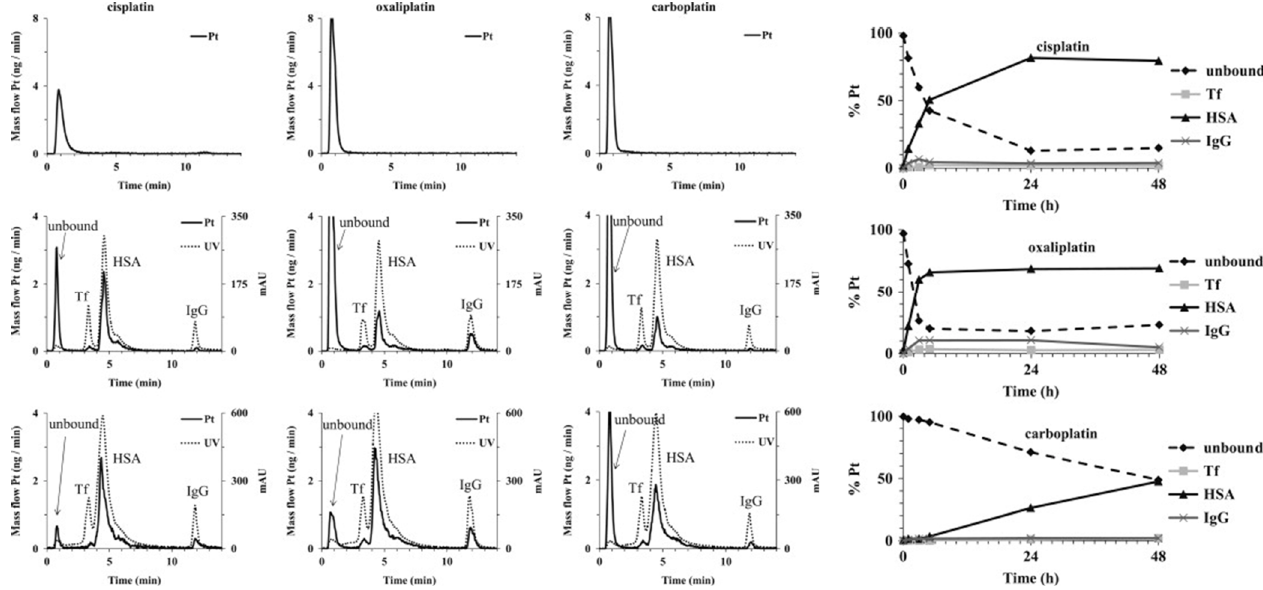
Figure 2. Two-dimensional separation of solutions of cisplatin, oxaliplatin, and carboplatin (20–40 ng Pt·mL − 1 ) (upper row) on a conjoint LC (CLC) monolithic column followed by ICP-MS detection and 5-times diluted samples of mixtures of standard serum proteins and serum samples spiked with single Pt-based chemotherapeutics (100–200 ng Pt·mL − 1 , incubation time 24 h) (middle and lower row, respectively), followed by UV (278 nm) and ICP-MS detection (Pt mass flow is based on the measurement of isotope ratios at m / z 194 and 195). The right panel shows the interaction kinetics of cisplatin, oxaliplatin, and carboplatin with serum proteins and the distribution of Pt-based chemotherapeutics in human serum. Reprinted with permission from [79]. Copyright Elsevier 2013.